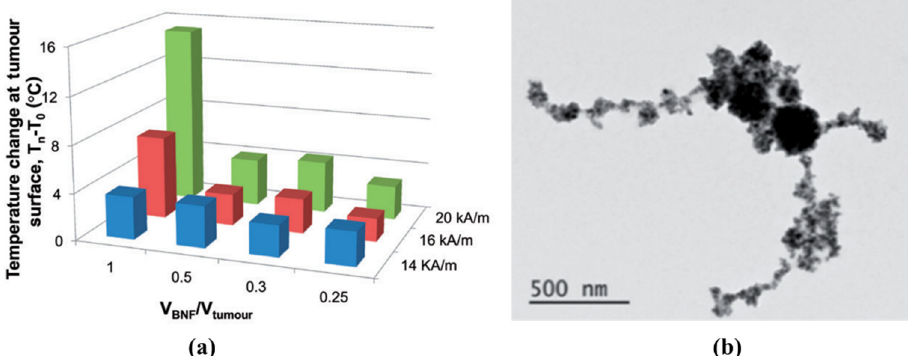
Figure 14. ( a ) Temperature change at the tumors of mice with hepatocellular carcinoma after injection of magnetite NPs emulsion in Lipiodol (cBNf-lip) followed by MH at 155 kHz and amplitudes within 14–28 kA/m. ( b ) TEM image of cBNf-lip. Reprinted with permission [62]. Copyright 2021, Taylor & Francis.